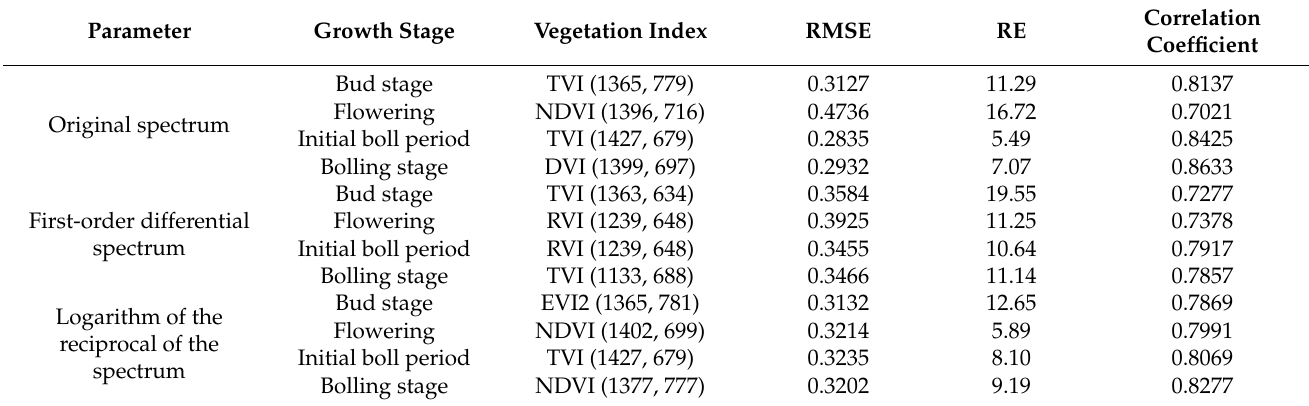
Table 6. Validation of the model to monitor the LAI in different growth stages of